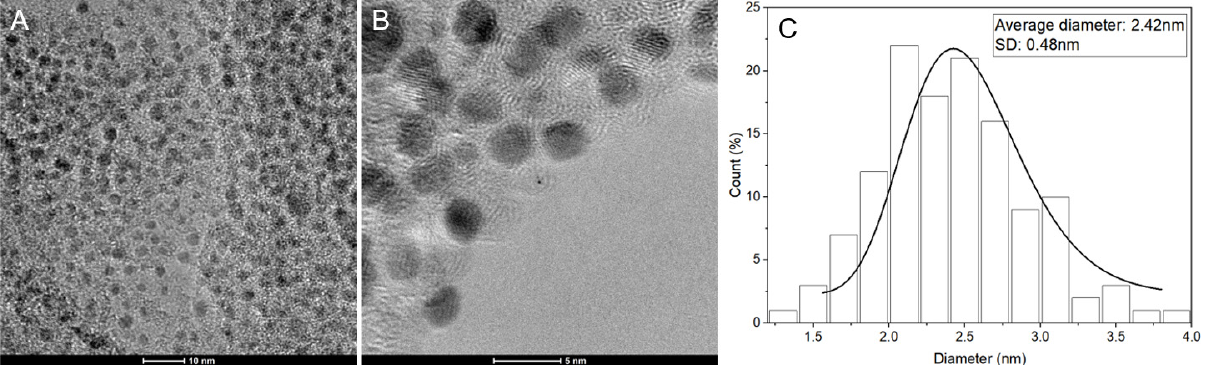
Figure 7. Characterization of the AgNPs synthesized with a mixture of lemon, orange, and grapefruit peels extract. ( A ) TEM micrograph of the AgNPs. ( B ) High-resolution TEM micrograph of the AgNPs. ( C ) Histogram showing the particle size distribution.